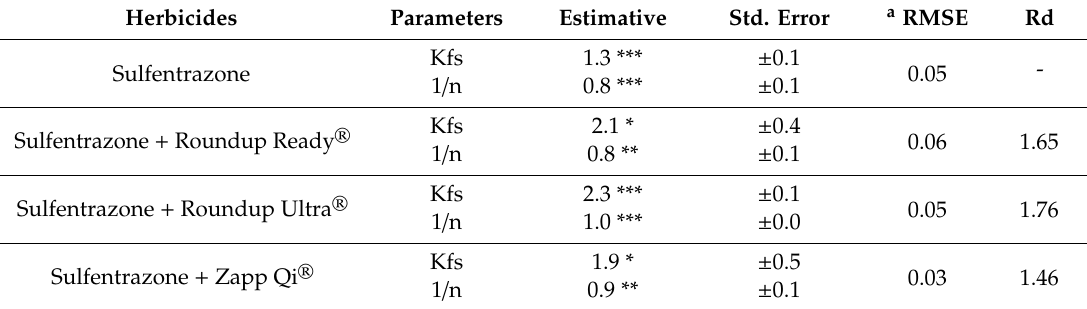
Figure 2. Sorption and desorption isotherms adjusted to the Freundlich model for sulfentrazone alone and mixed with glyphosate formulation. Table 3. Parameters of the sorption isotherms and ratio adsorption capacities (Rd) for sulfentrazone in isolation and mixed with glyphosate formulations.